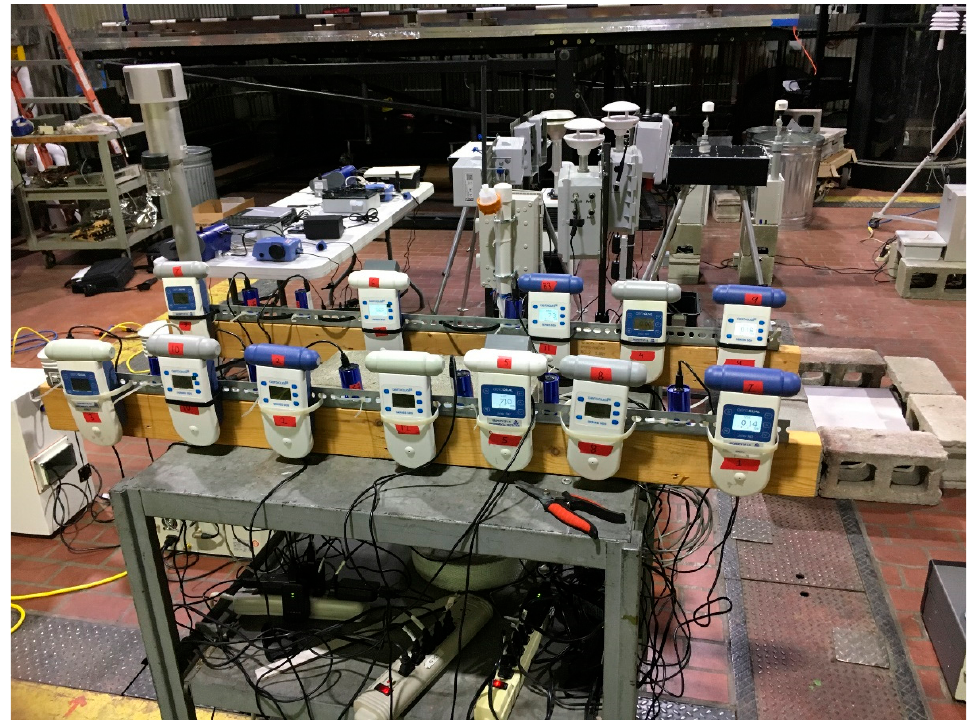
Figure 4. Photograph of Aeroqual and Cairpol sensors in the FSL.